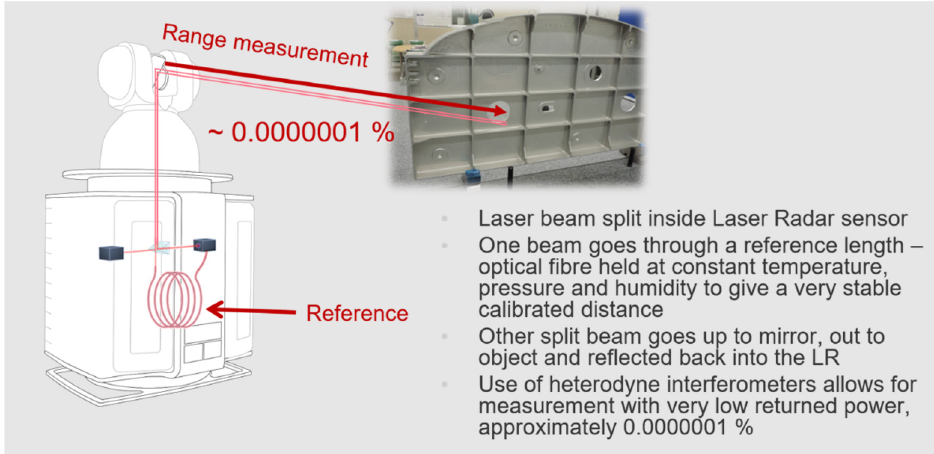
Figure 6. The principal functional operation of a laser radar. By the courtesy of LK Scandinavia.